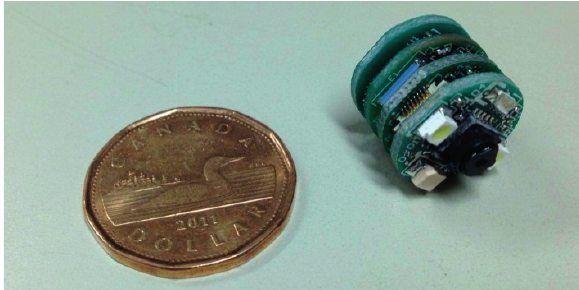
Figure 9. Photograph of the capsule prototype (size compared with a 26.5 mm diameter 1$ Canadian